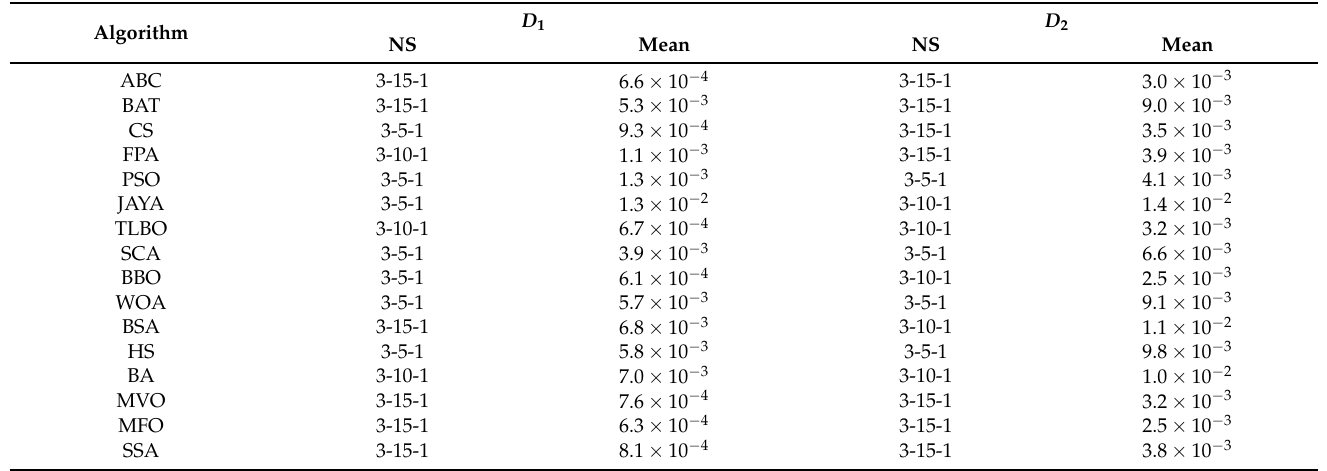
Table 11. The best test results obtained with the relevant metaheuristic algorithms for D 1 and D 2 (NS: network